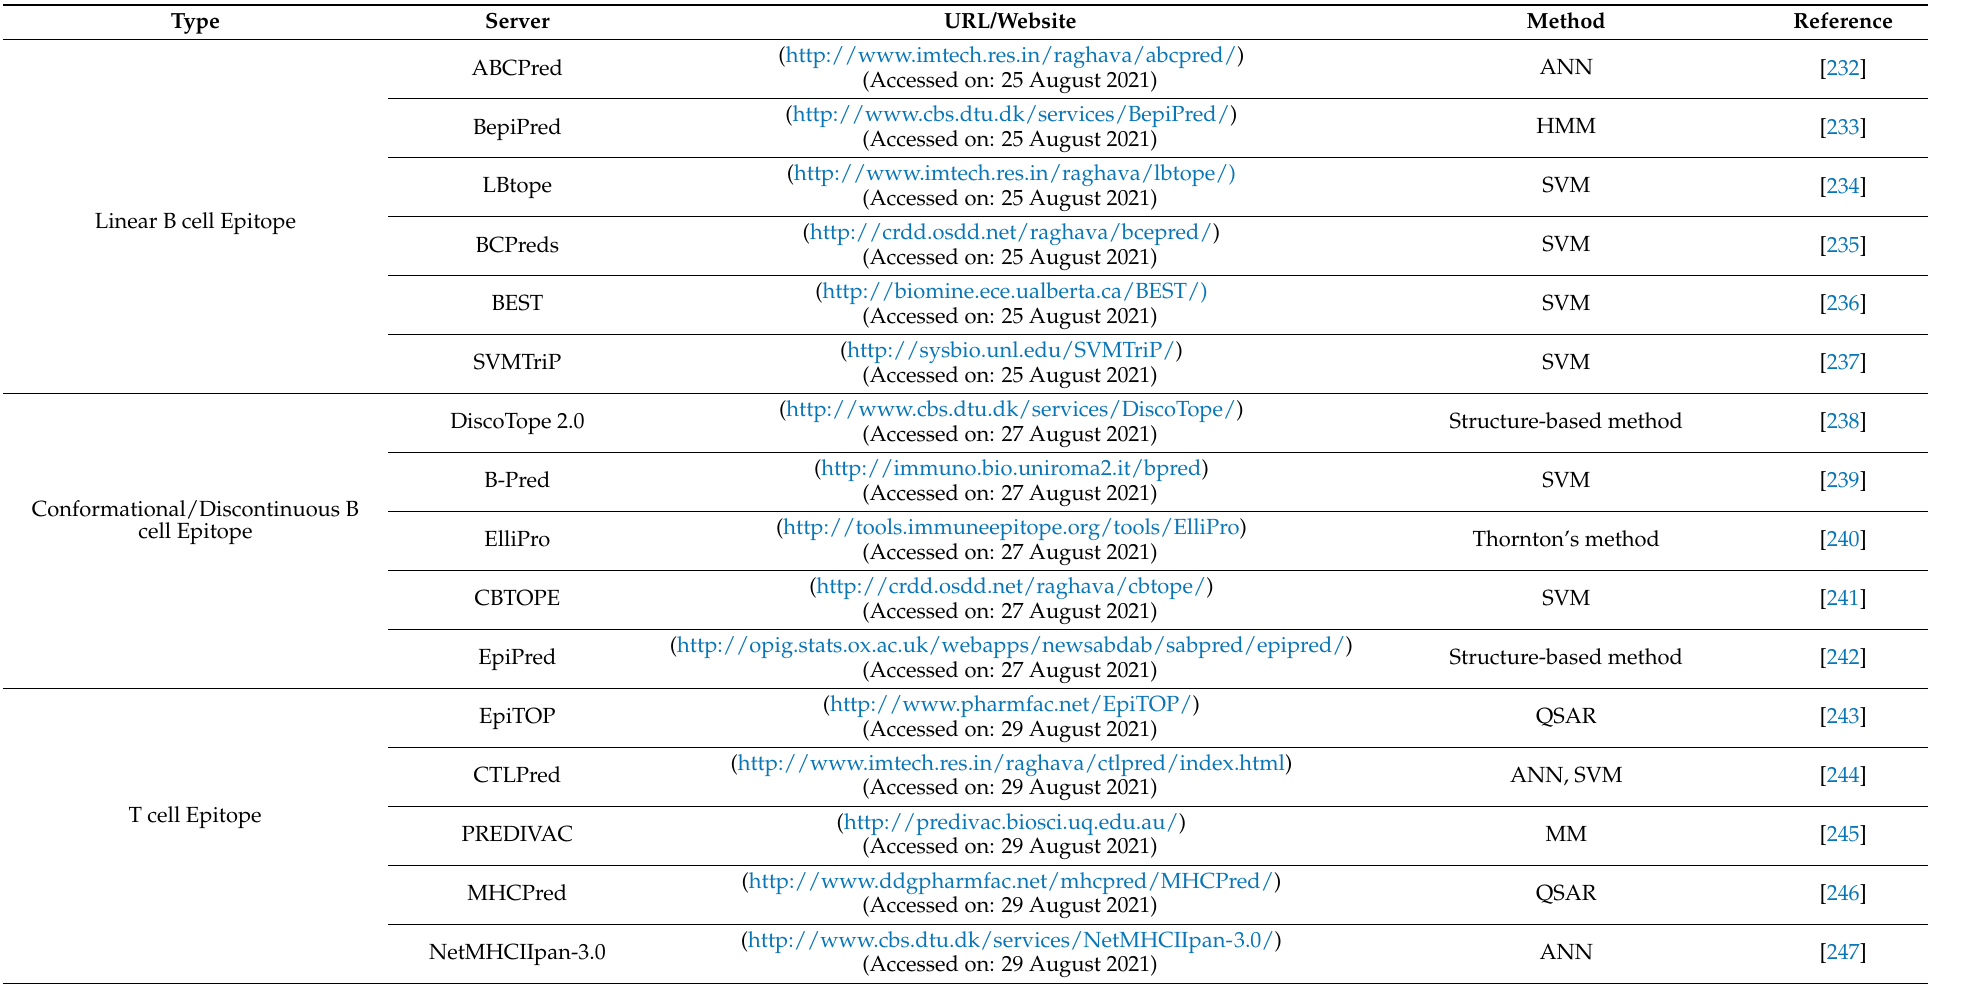
Table 4. Tools/servers for B cell and T cell epitopes